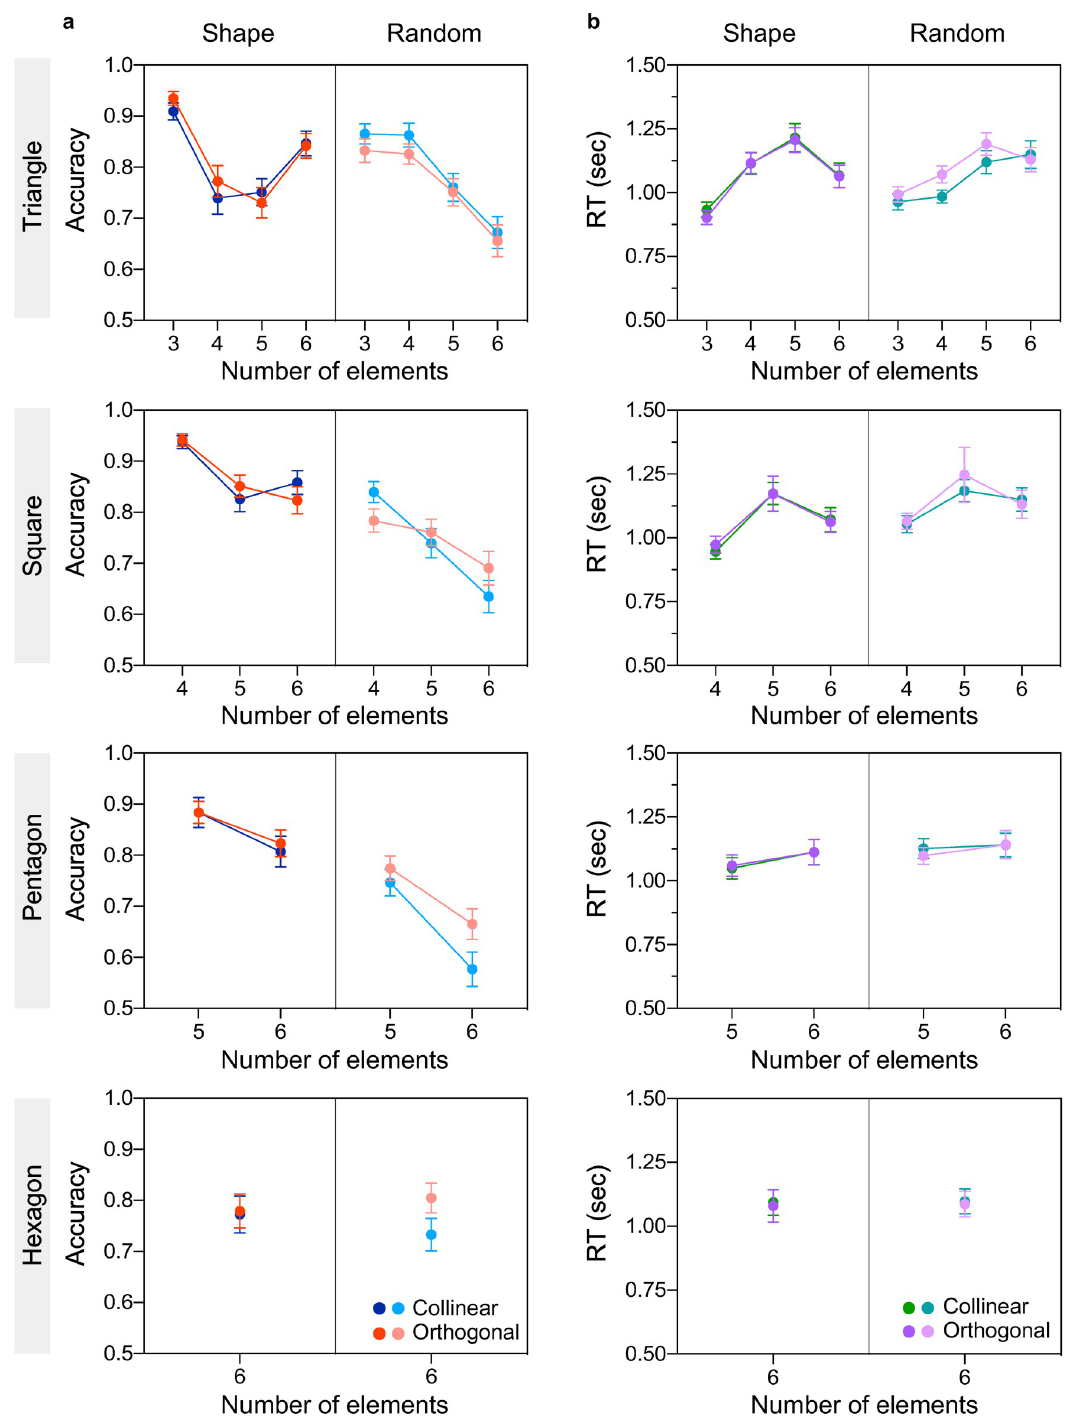
Fig 5. Experiment 3 results (effect of orientation). (a) Accuracy and (b) reaction time are plotted as a function of number of elements for simple shape (left side of each panel) and random (right side of each panel) configurations, and for colinear (blue/green symbols) and orthogonal (red/purple symbols) to contour-path orientation conditions. Top to bottom panels correspond to different simple shape configurations: Equilateral triangle (top panel), square, pentagons and hexagon (bottom panel) configuration. The error bars indicate standard error of the mean ( ± 1